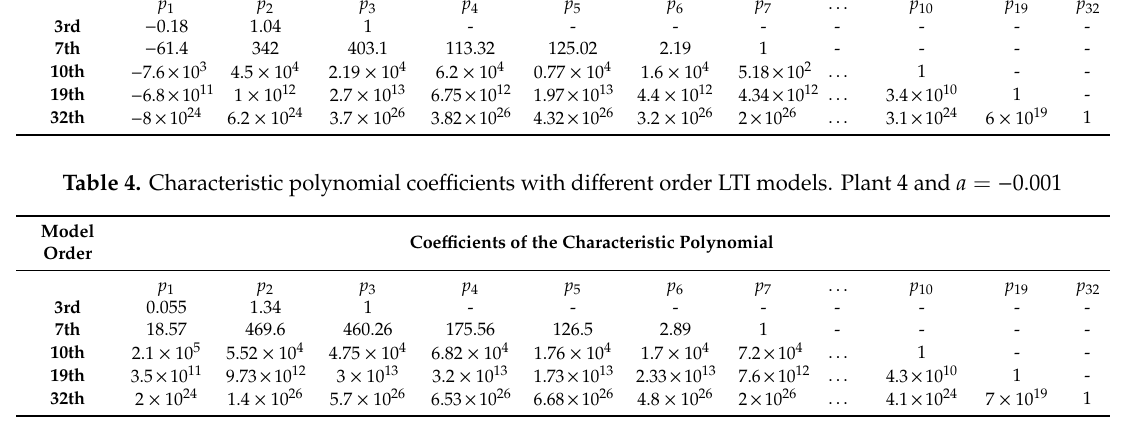
Table 3. Characteristic polynomial coe ffi cients with di ff erent order LTI models. Plant 4 and a = − 0.1 Model Order